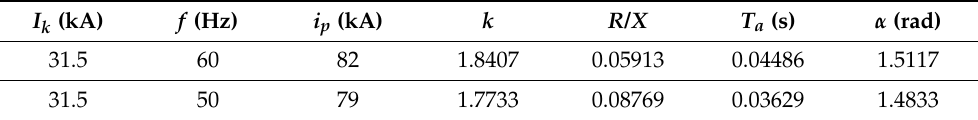
Table 1. Three-phase short-circuit current parameters.